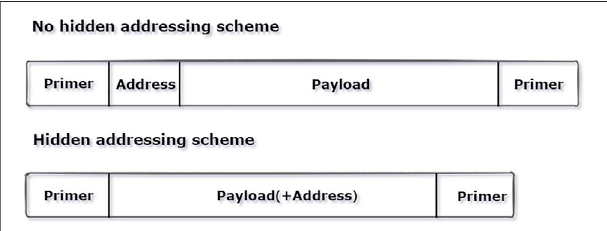
FIGURE 2 | Comparison of the required sequence lengths with and without the hidden addressing